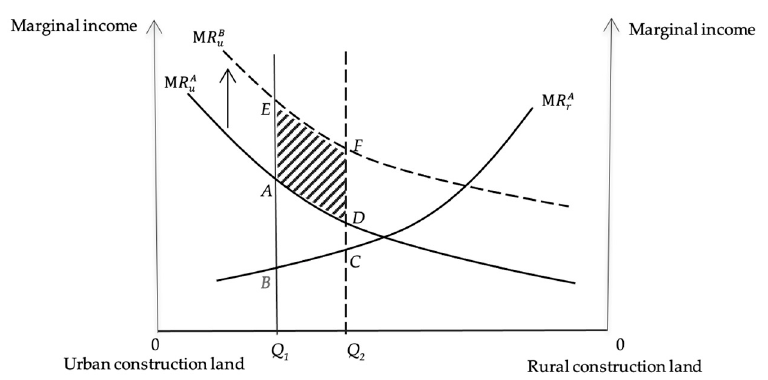
Figure 2. Influence of construction land quota trading on efficiency of land allocation.